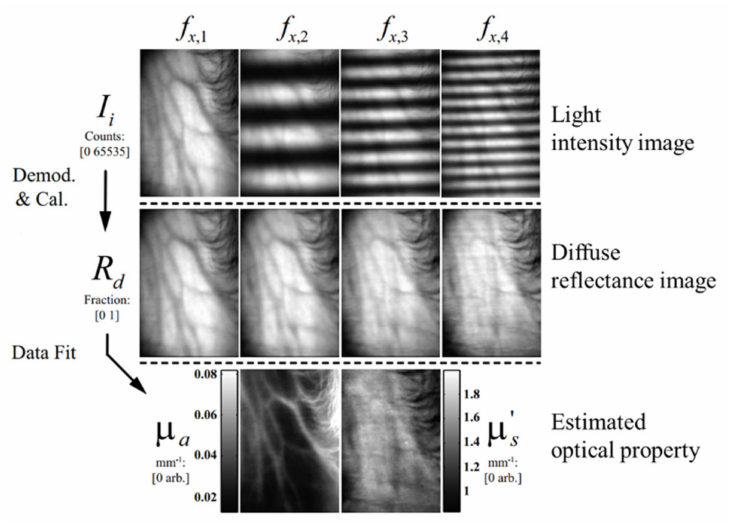
Figure 2. Flow chart of data processing for estimating optical properties of biological tissues by using the spatial-frequency domain imaging technique (adapted from Ref.